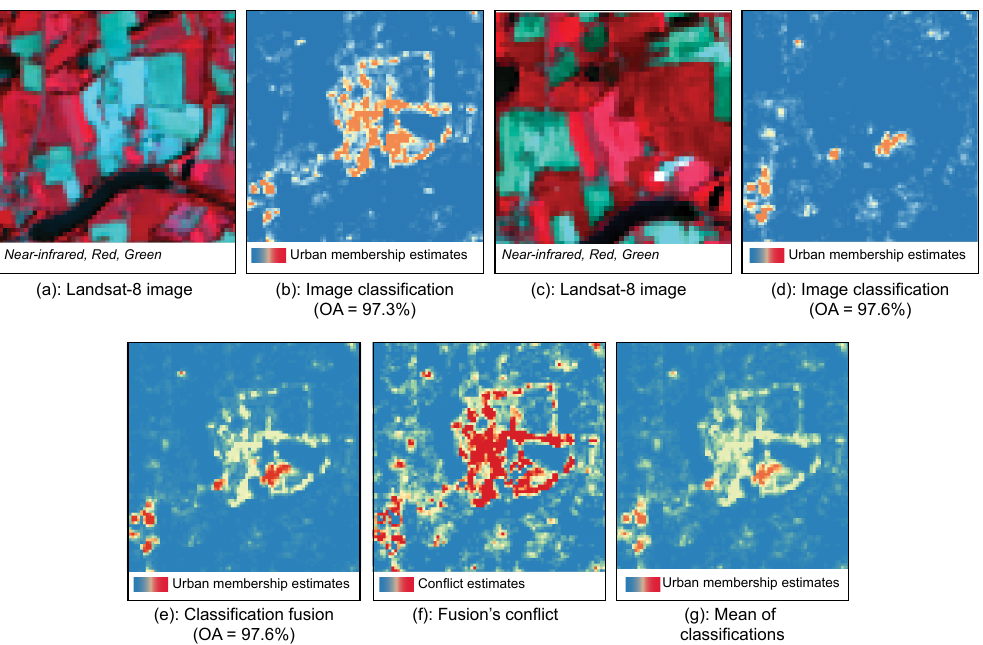
Figure 9. Benefits of the multi-temporal fusion: classification fusion promotes common estimates, whereas the mean of classifications provides less obvious estimation between urban areas and other land covers. ( a ) Landsat-8 image; ( b ) Image classification (OA = 97.3%); ( c ) Landsat-8 image; ( d ) Image classification (OA = 97.6%); ( e ) Classification fusion (97.6%); ( f ) Classification’s conflict; ( g ) Mean of classifications).